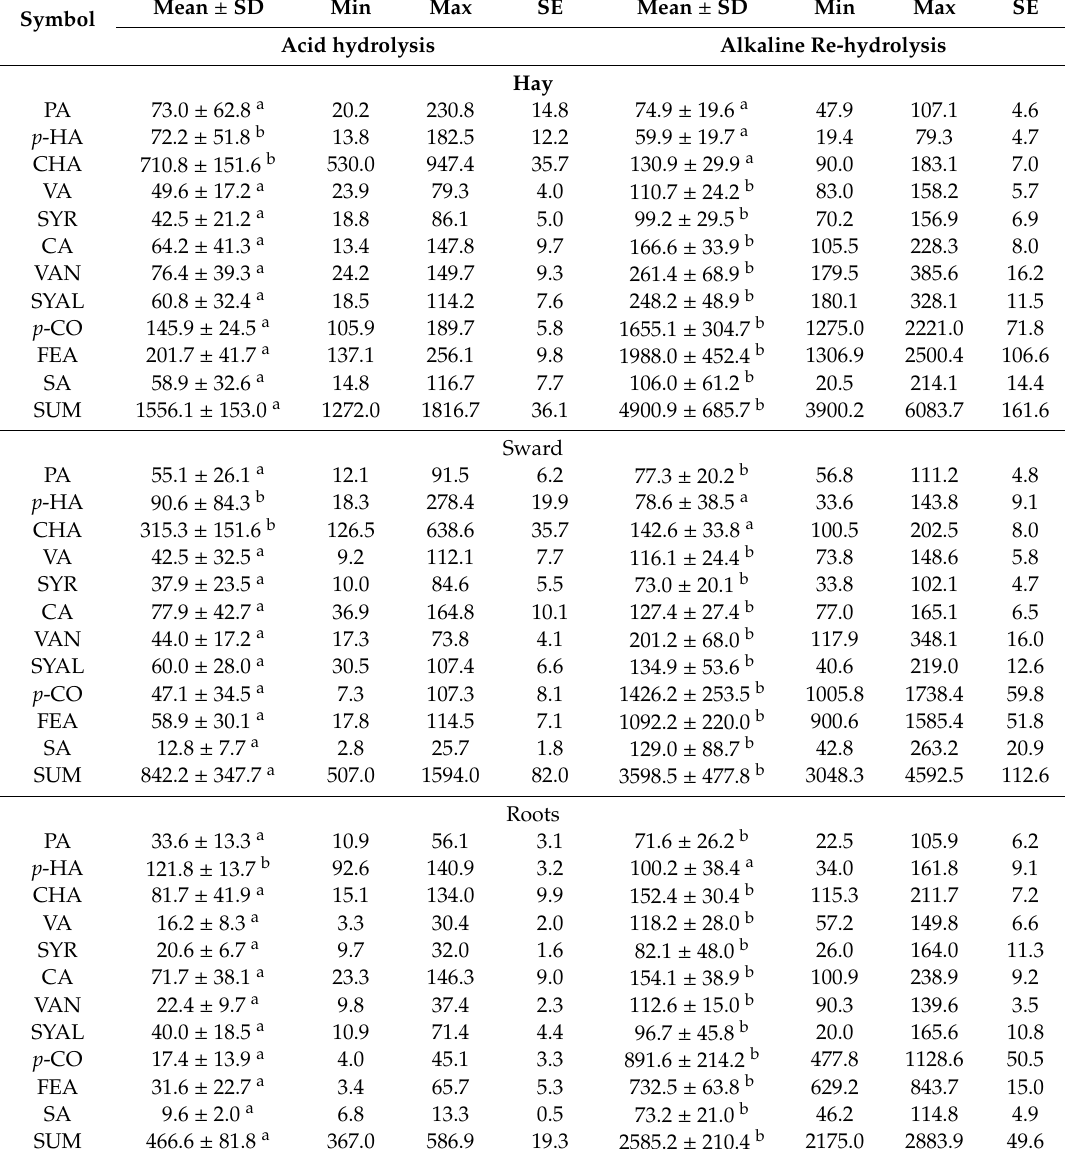
Table 1. Content of phenolic compounds in plant material ( µ g / g